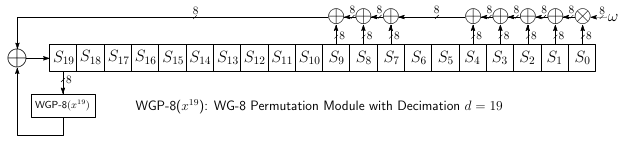
Figure 1. The Initialization Phase of the Stream Cipher